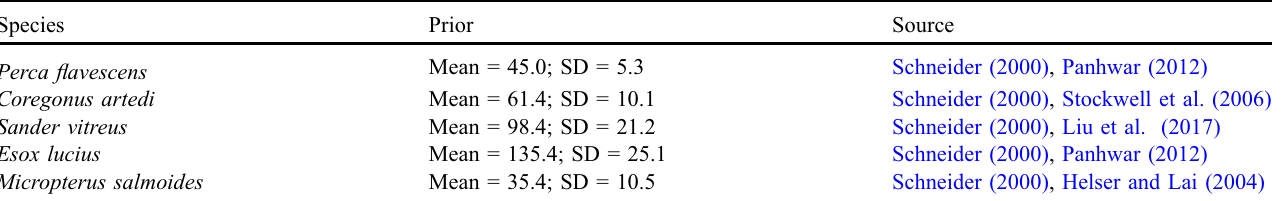
Table 3. Mean and standard deviations (SD) for lognormal prior distributions used for asymptotic length ( L ∞ ) for fi ve freshwater fi sh used in Bayesian